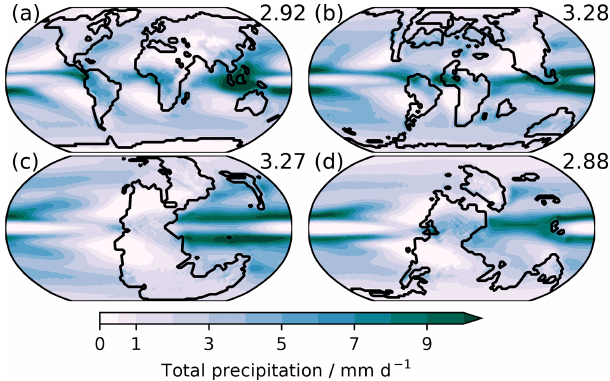
Figure 3. Annual average precipitation simulated in (a) PI-CM 21 , (b) Ma-CM 21 , (c) Wu-CM 21 and (d) As-CM 21 . Global-mean val- ues are indicated in the top right. Continental outlines are indicated with a solid black